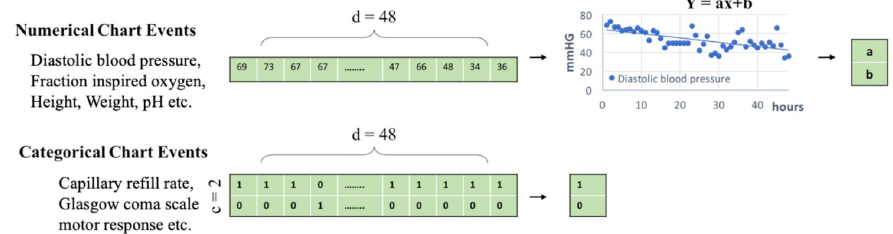
Fig 1. Statistical feature computation. For numerical chart events, we conduct linear regression on the 48-hour data points and record the rate and bias value as the feature. For categorical events, we simply compute the average occurrence of the categories.